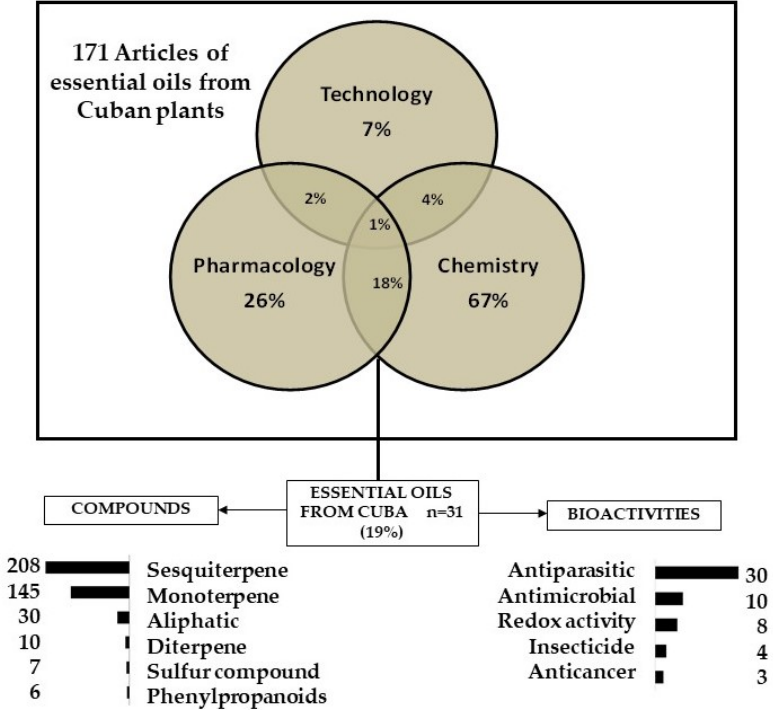
Figure 1. Scheme illustrating the main results retrieved of studies related to essential oils from Cuban plants.